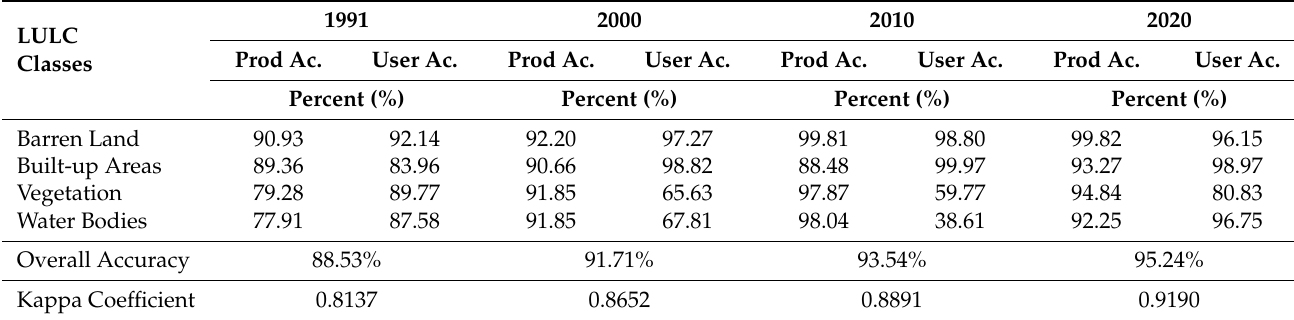
Table 7. Accuracy Assessment of classified LULC